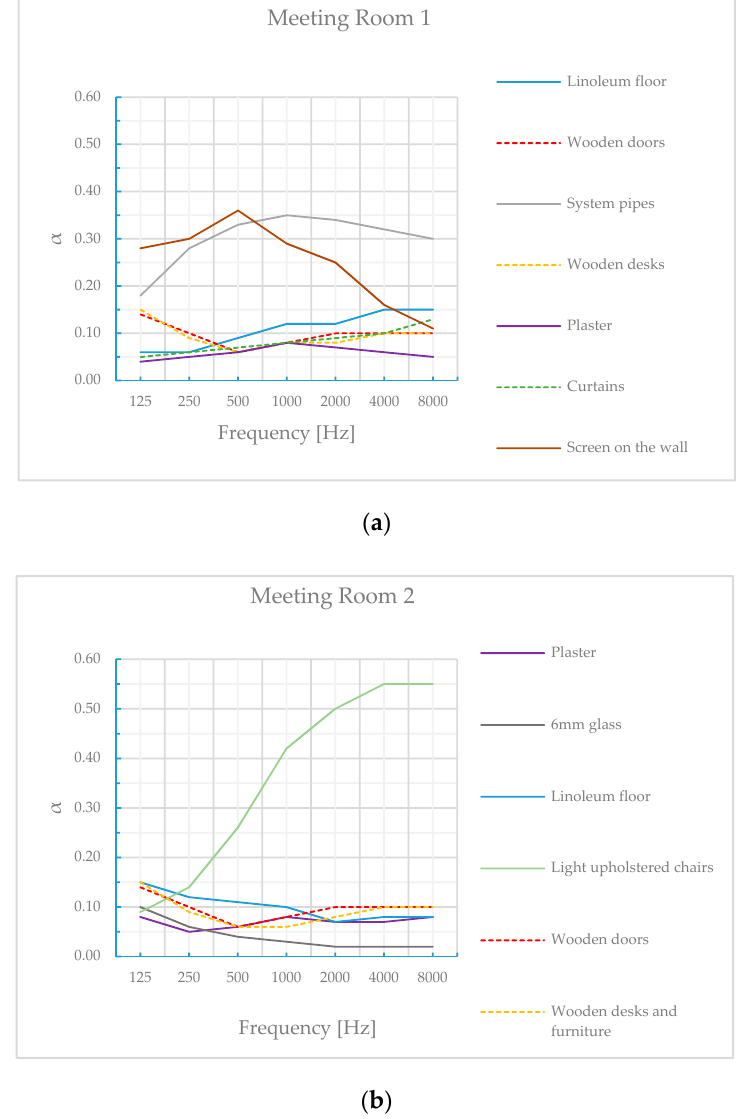
Figure 3. Octave band absorption coefficients assigned to materials for calibration in the two meeting rooms: ( a ) meeting room 1; ( b ) meeting room 2.